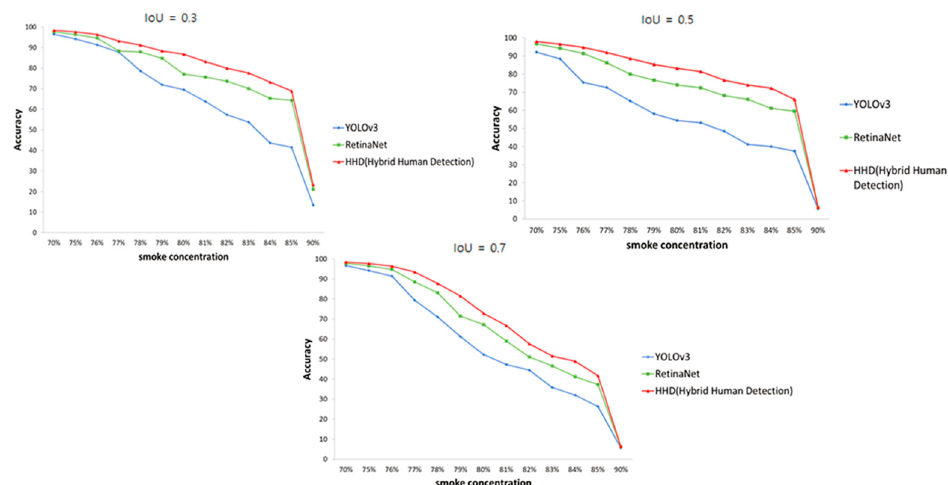
Figure 12. Accuracy of the YOLO, RetinaNet, and HHD methods vs. smoke concentration for IoU